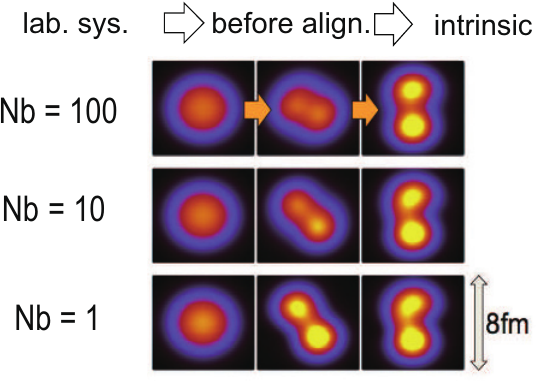
Figure 1. 8 Be proton densities in the laboratory system with J -projected states, | Ψ i , (left) and before alignment of principal axes of unprojected basis states, | Φ i , (middle) and of intrinsic state, | Φ intr i , (right) for various N b and slices along y z plane. The numbers of basis states are N b = 1 , 10 and 100 for the lower, middle and upper figures, respectively. Slices along y z plane are x = 0 fm plane for each figure. The size of each box is 8 fm × 8 fm. The model space and harmonic oscillator energy are N shell = 4 and ~ ω = 20 MeV,